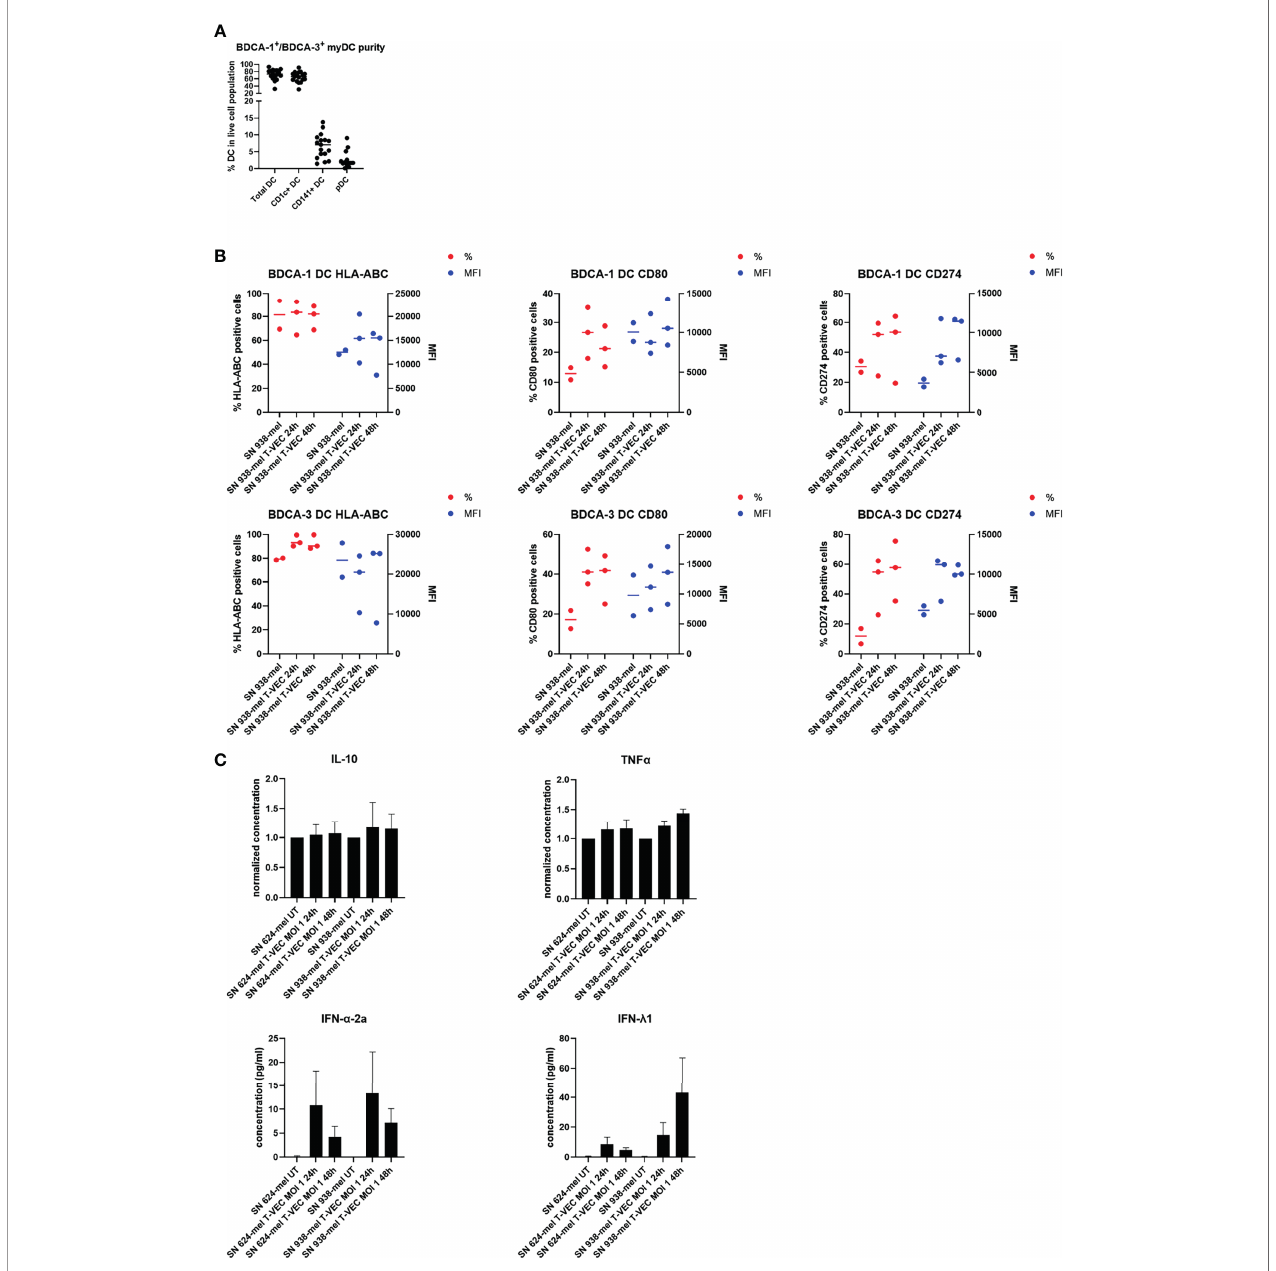
FIGURE 2 | Effect of supernatant from T-VEC-treated melanoma cells on puri fi ed BDCA-1 + /BDCA-3 + myDC. (A) The purity of the puri fi ed BDCA-1 + /BDCA-3 + myDC was analyzed by fl ow cytometry. This graph depicts the percentage of each DC subpopulation in the live cell population. (B) BDCA-1 + /BDCA-3 + myDC were incubated for 24h with supernatant from untreated 938-mel cells, supernatant from 938-mel cells treated with T-VEC (MOI 1) during 24h or supernatant from 938-mel cells treated with T-VEC (MOI 1) during 48 h. After 24 h, the phenotype of the DC was analyzed by fl ow cytometry. On the left y-axis (red symbols) the percentage of expression of each marker is depicted and on the right y-axis (blue symbols) the mean fl uorescence intensity (MFI) is plotted. Each symbol represents the result of an independent experiment, and the line represents the median. (C) On the supernatants from the cultures described in (B) , cytokine content was analyzed using MesoScale Diagnostics assays. For IL-10 and TNF a , concentrations were normalized to the conditions with supernatant from untreated tumor cells (either 624-mel or 938- mel) because the absolute cytokine concentrations showed high variation among donors. For IFN- a -2a and IFN- l 1, the actual concentrations are plotted. The graphs depict mean values ± standard error of mean (SEM) and represent data from 6 independent